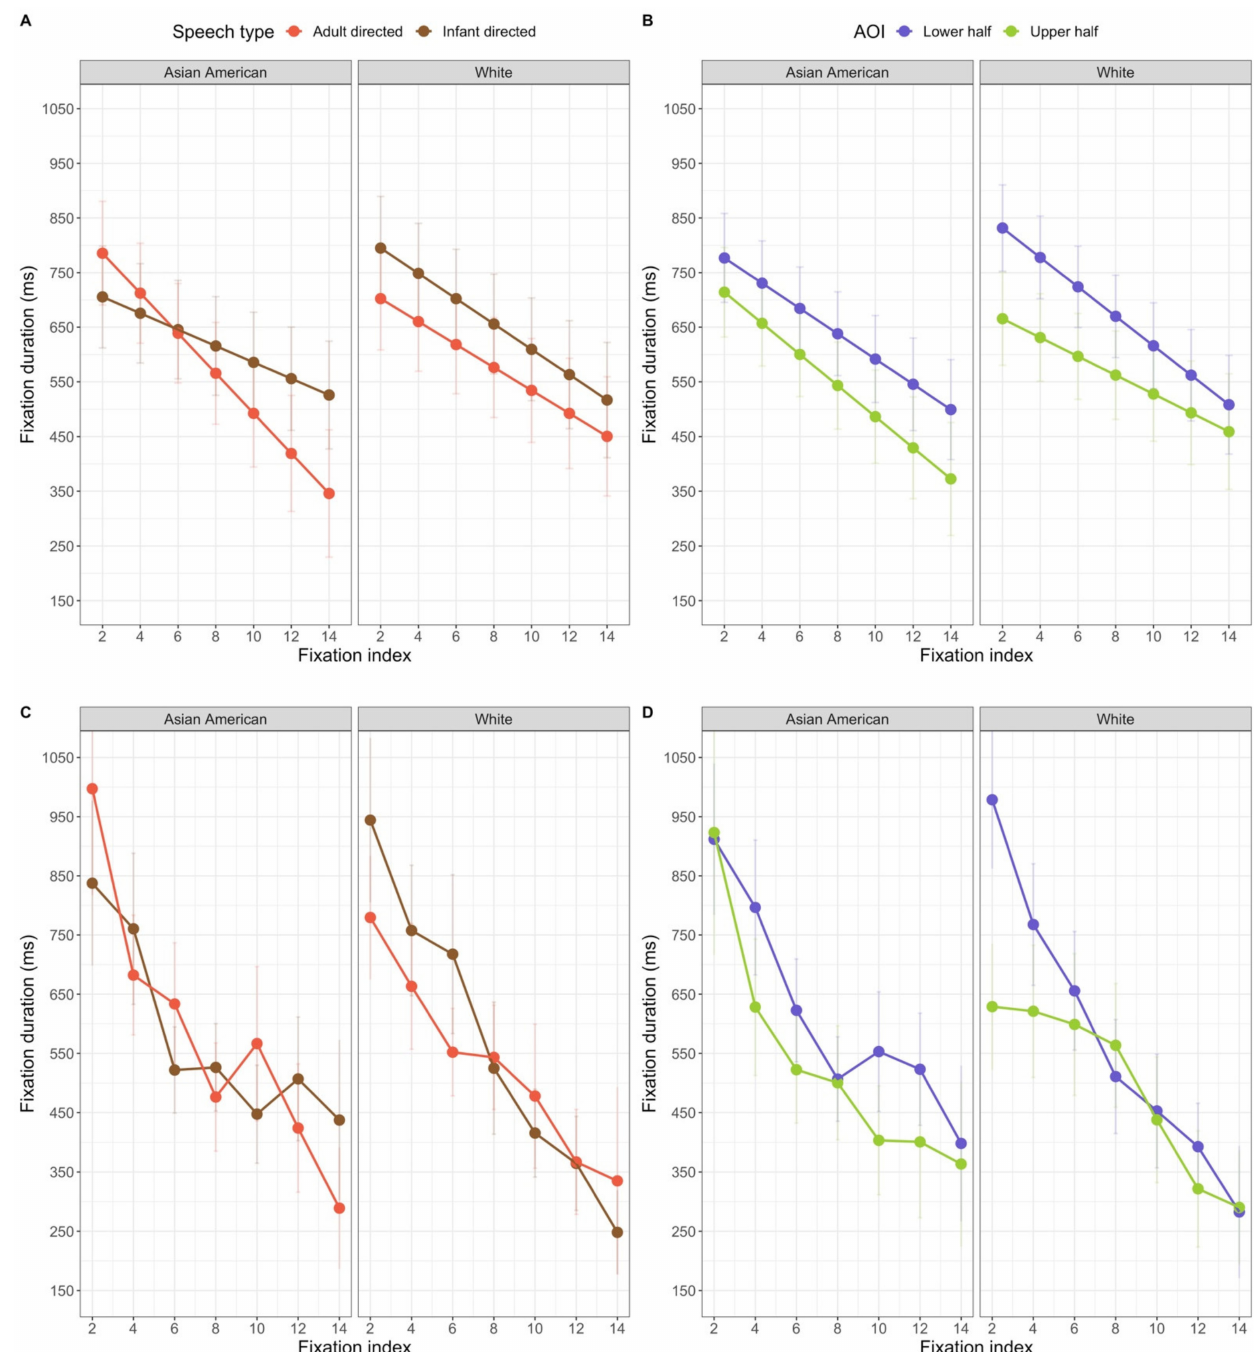
Figure 8. Top: The estimated marginal means for the duration of fixations as a function of ( A ) face race, speech type and fixation index and ( B ) face race, AOI, and fixation index ( B ), taken from the model including diversity of experience. Bottom: The observed means for the interactions of ( C ) face race, speech type, and fixation index, and ( D ) face race, AOI, and fixation index. Error bars represent non-adjusted 95% confidence intervals. Although fixations are only plotted to fixation index 14, all fixations were entered in the